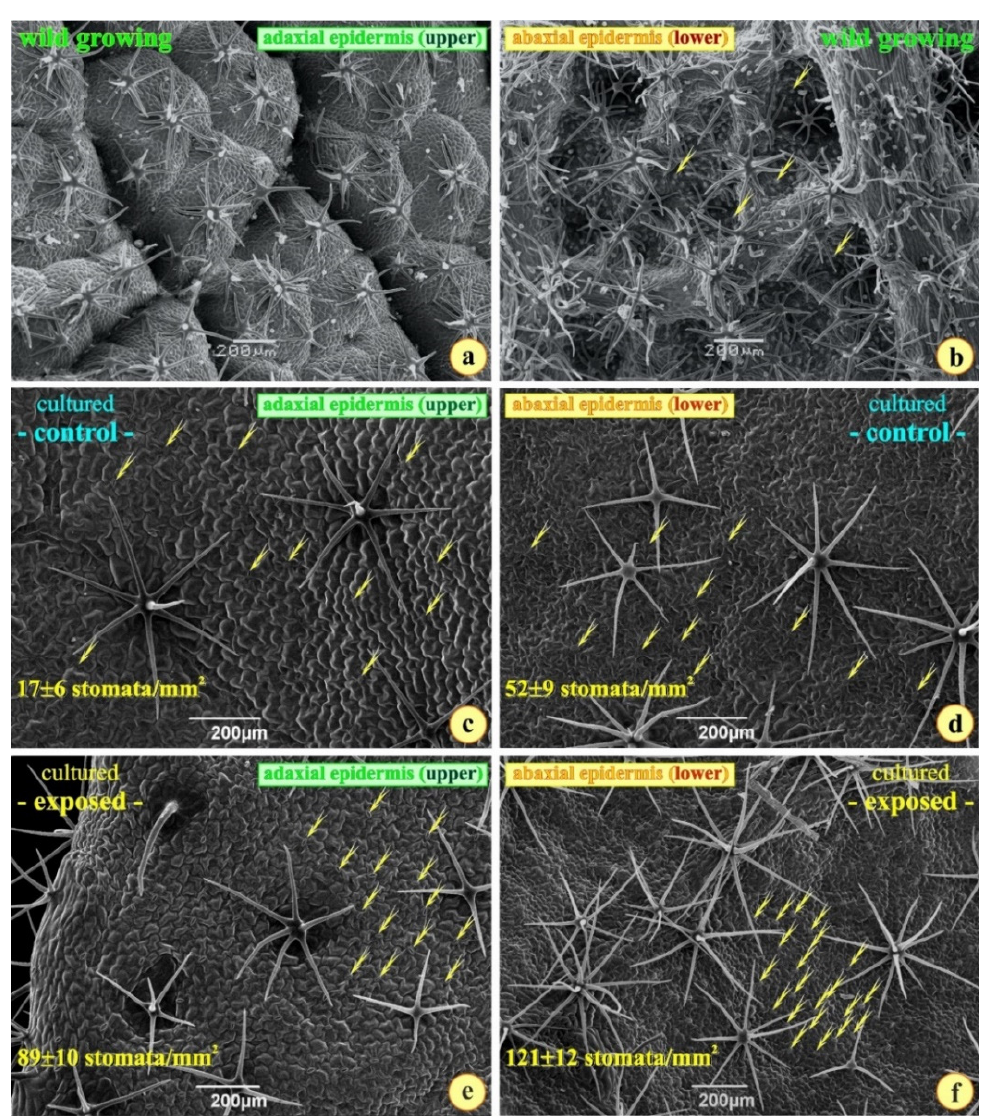
Figure 8. ( a ) The upper epidermis of the leaf from a wild-growing plant. Stomata are absent. ( b ) The lower epidermis of the leaf from a wild-growing plant. Notice the thick pubescence. Some of the stomata are pointed out by arrows. ( c ) The upper epidermis of the leaves of the “control” plants. Hair and stomata appear sporadically. ( d ) The lower epidermis of the leaves of the